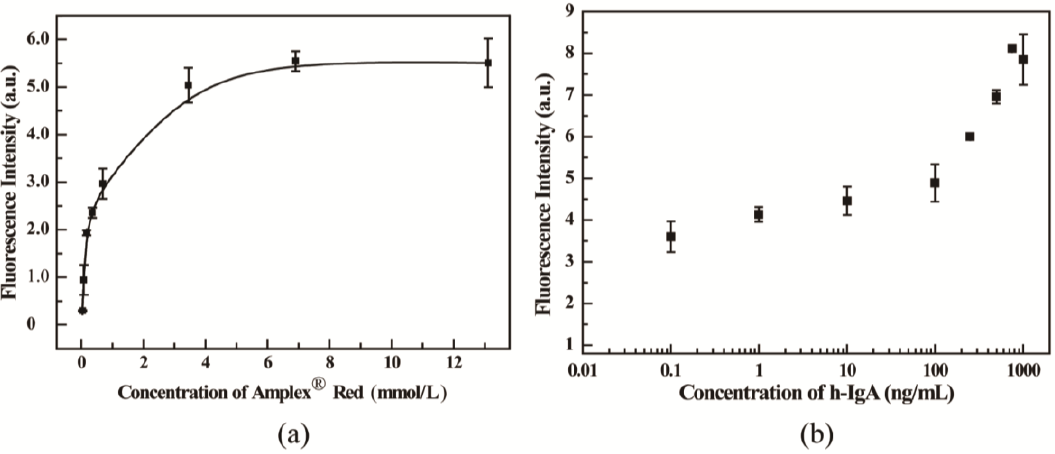
Figure 5. Effects of the substrate concentrations on the enzyme catalytic reaction performed in the present method, the other conditions were used with the optimal ones as the former works investigated ( a ). Plot for h-IgA detected by the present method under the optimized conditions ( b ).